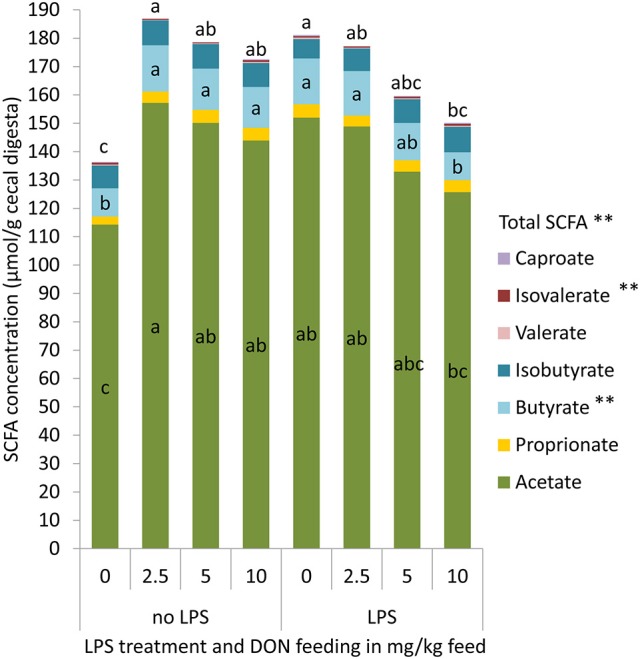
Total short chain fatty acids (SCFA), acetate, proprionate, butyrate, isobutyrate, valerate, isovalerate, and caproate concentrations in cecal digesta of chickens fed diets with increasing levels of deoxynivalenol (DON; 0, 2.5, 5, or 10 mg DON/kg diet) and with or without oral lipopolysaccharide challenge (LPS) 1 day prior to slaughter. Values are presented as least squares means ± standard error of the mean (SEM); n = 10 broilers per treatment; n = 9 in the 5 DON+con and 5 DON+lps groups. a,b,c DON × LPS interaction: Least squares means of total or individual SCFA with no common superscripts differ significantly between groups; p < 0.05. **Quadratic contrast: p < 0.05.